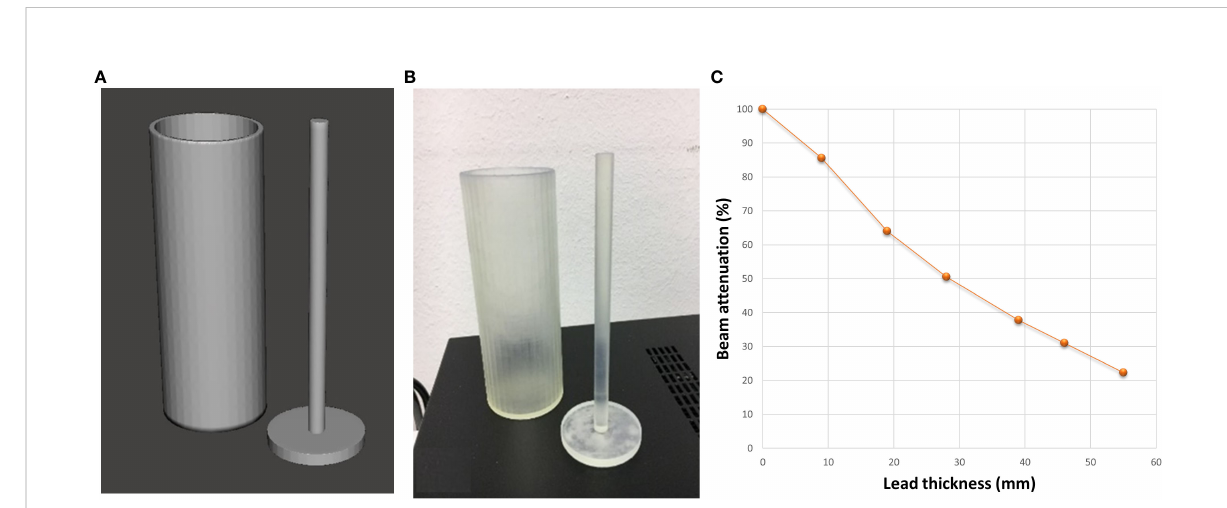
FIGURE 5 Digital (A) and 3D-printed (B) models of the ad-hoc cylinder used to determine the fi lling level of the lung blocks with lead spheres. (C) Photon diode-measured % beam attenuation against the thickness of cylinder fi lled with lead spheres.